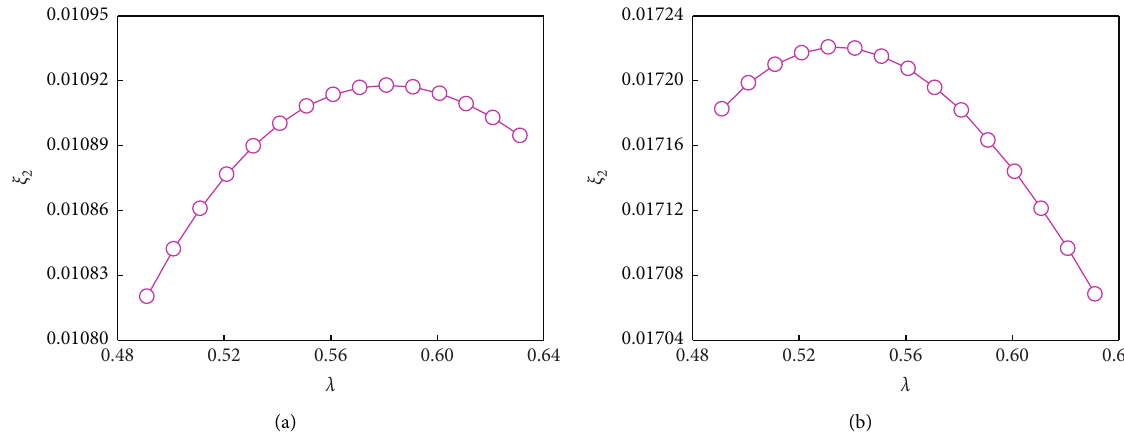
Figure 13: Variations of the second additional modal damping ratio ξ analysis